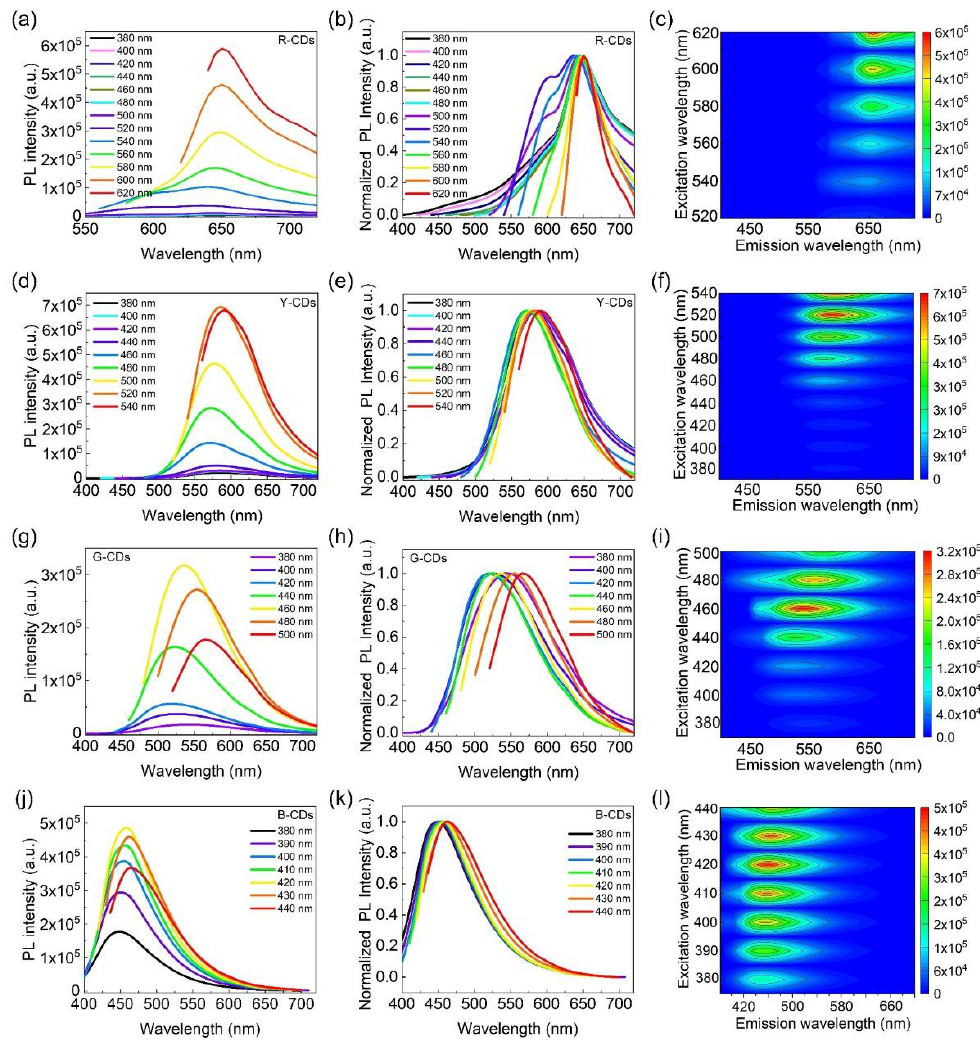
Figure 5. PL emission spectra of the R-CDs ( a ), Y-CDs ( d ), G-CDs ( g ), and B-CDs ( j ) under different excitation wavelengths. Normalized PL emission spectra of R-CDs ( b ), Y-CDs ( e ), G-CDs ( h ), and B-CDs ( k ) under different excitation wavelengths. Contour of the excitation spectra and emission spectra of R-CDs ( c ), Y-CDs ( f ), G-CDs ( i ), and B-CDs ( l